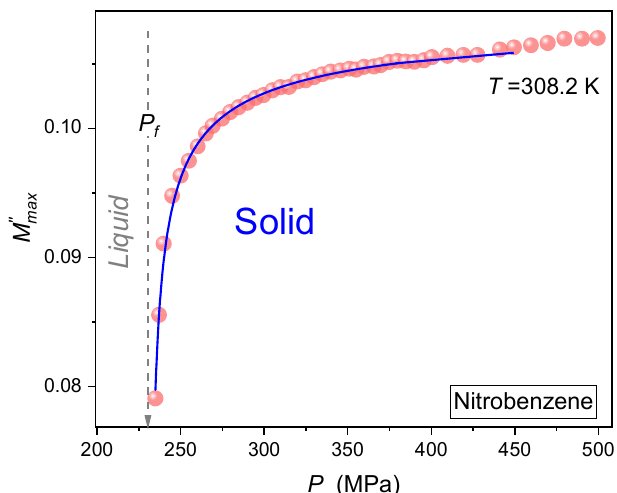
Figure 8. Premelting changes of the modulus loss curve maximum for isothermal compressing. The curve is for the critical-like portrayal (Equation (20)) with the amplitude A = − 0.062 K 1/2 , singular temperature P ∗ = 232.0 MPa, the exponent ψ = − 1/2, and C = 0.110 for the constant term related to the behavior remote from P + .